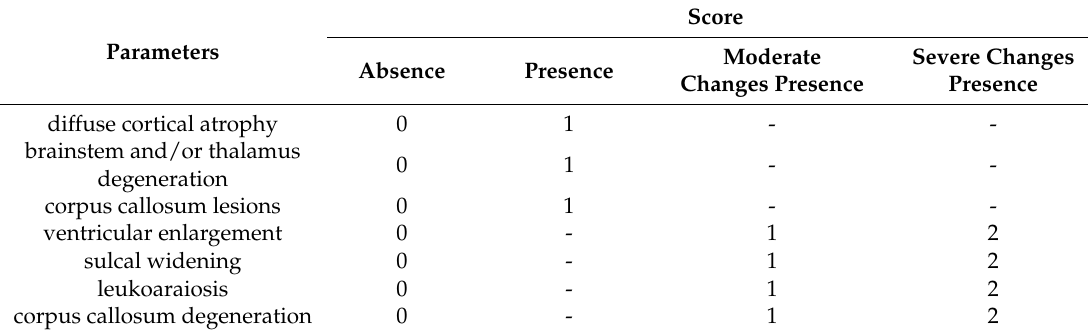
Table 1. MRI parameters for patient assessment and corresponding scores.